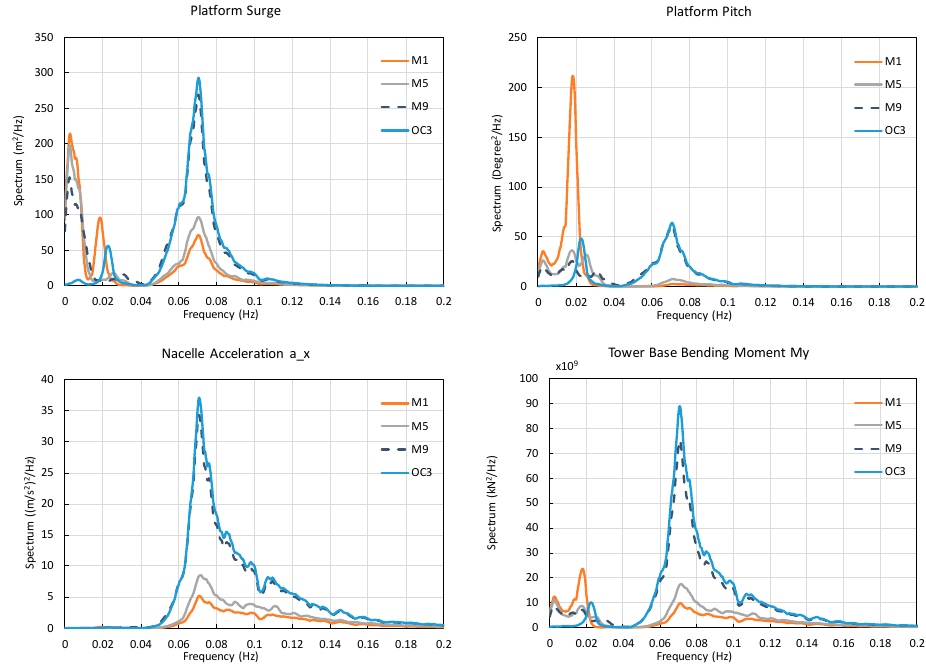
Figure 12. Spectrum of the FOWT systems at 12 m / s turbulent wind speed, irregular wave Hs = 12.12 m, Tp = 14.17 s, and 0.37 m / s current speed.